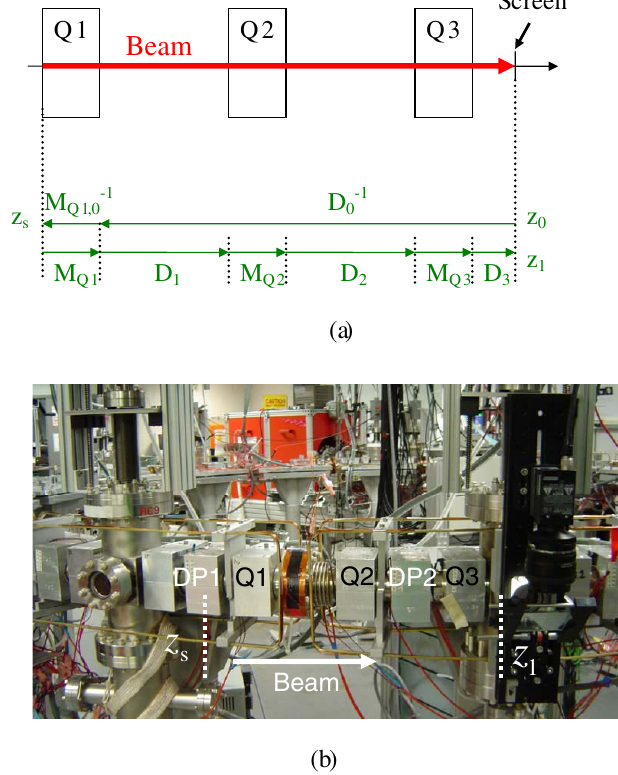
FIG. 1. (Color) Tomography experimental configuration: (a) simplified diagram; (b) actual experimental